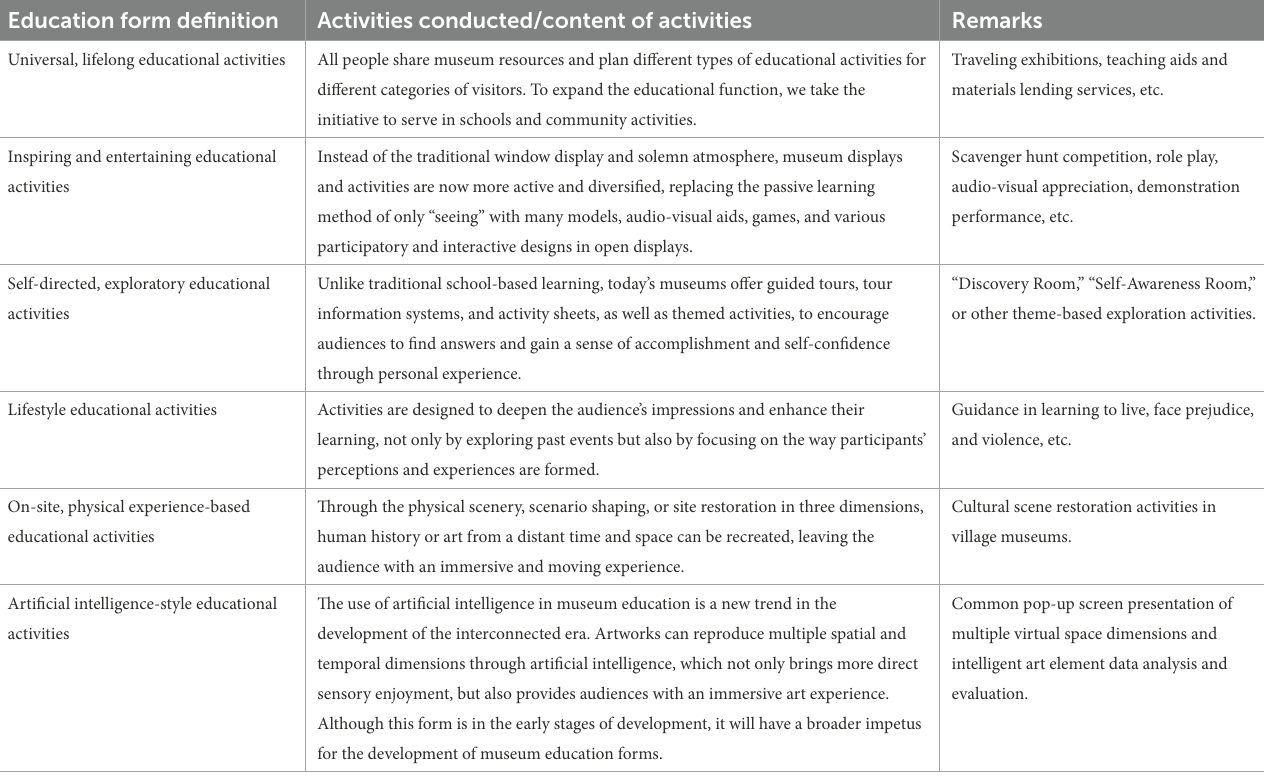
TABLE 2 Main forms of museum educational